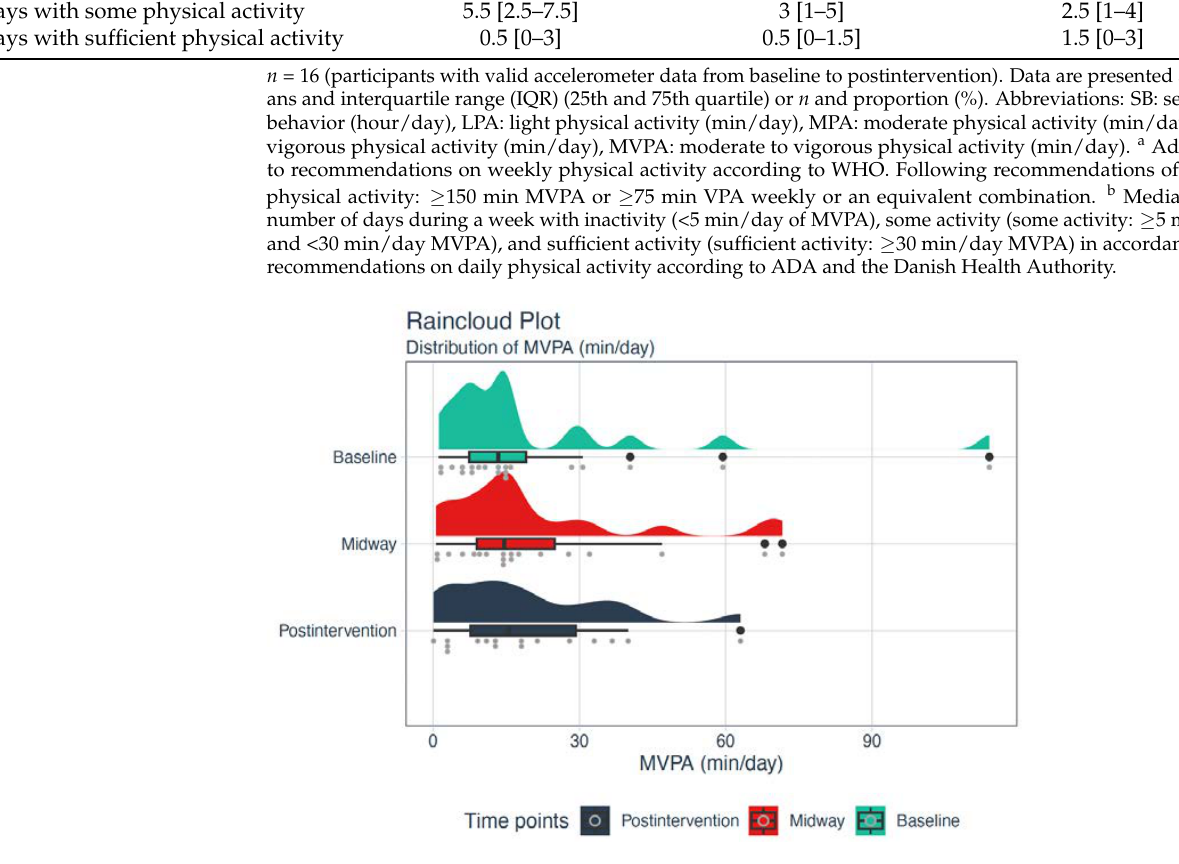
Figure 4. Raincloud plot representing an illustration of data in a half-density distribution (the ‘cloud’) with individual raw data (the ‘rain’) and a boxplot below the ‘cloud’ of the total daily steps at baseline, midway, and post-intervention.